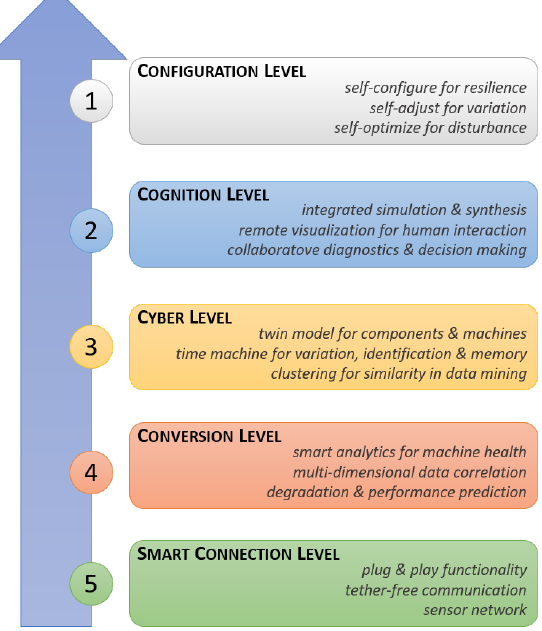
Figure 2. Five-layer architecture of CPS implemented in industrial settings. Lower levels collect data, which is analyzed and condensed at each upper level. With this configuration, information fed to each higher level is more valuable than information coming into the level